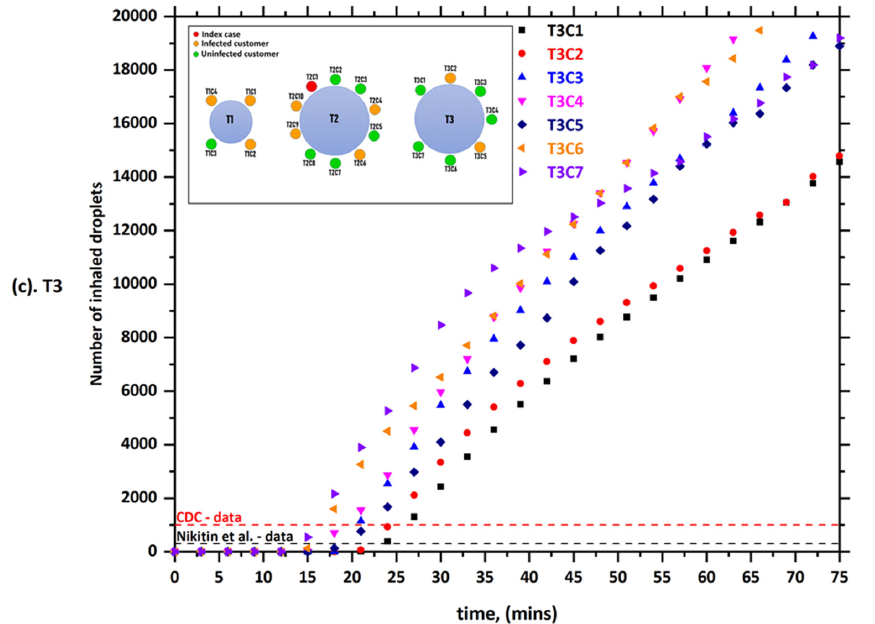
Figure 4. The number of inhaled droplets/particles by healthy individuals in a restaurant setting—case-2; ( a ) T1: table 1, ( b ) T2: table 2, and ( c ) T3: table 3 [35].